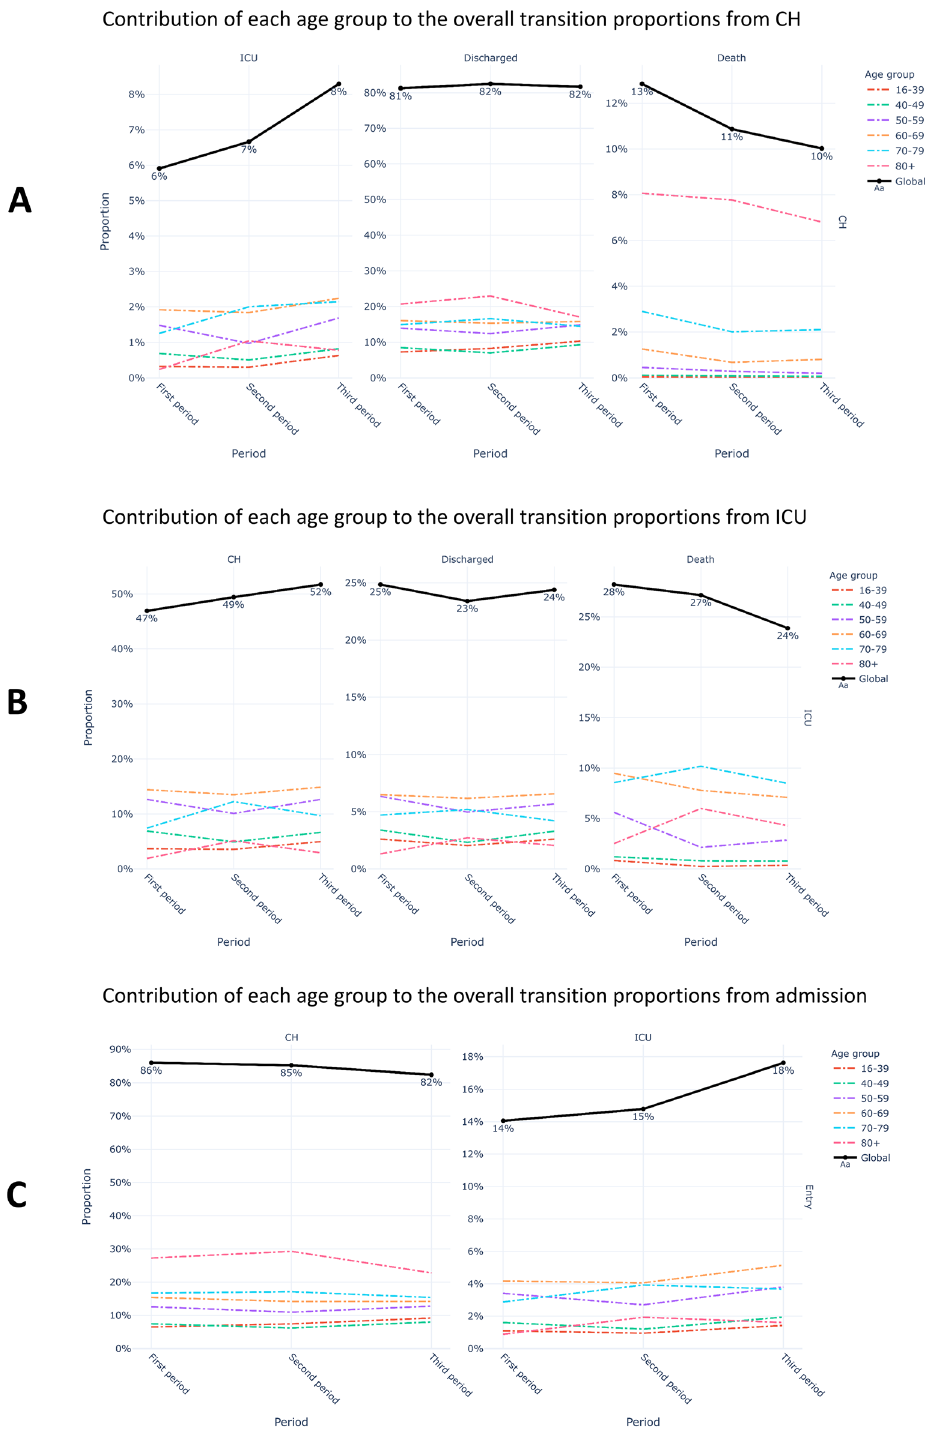
Figure 4. Evolution of the contribution of age in overall transition proportion. (A) From conventional hospitalization, (B) from ICU, (C) from